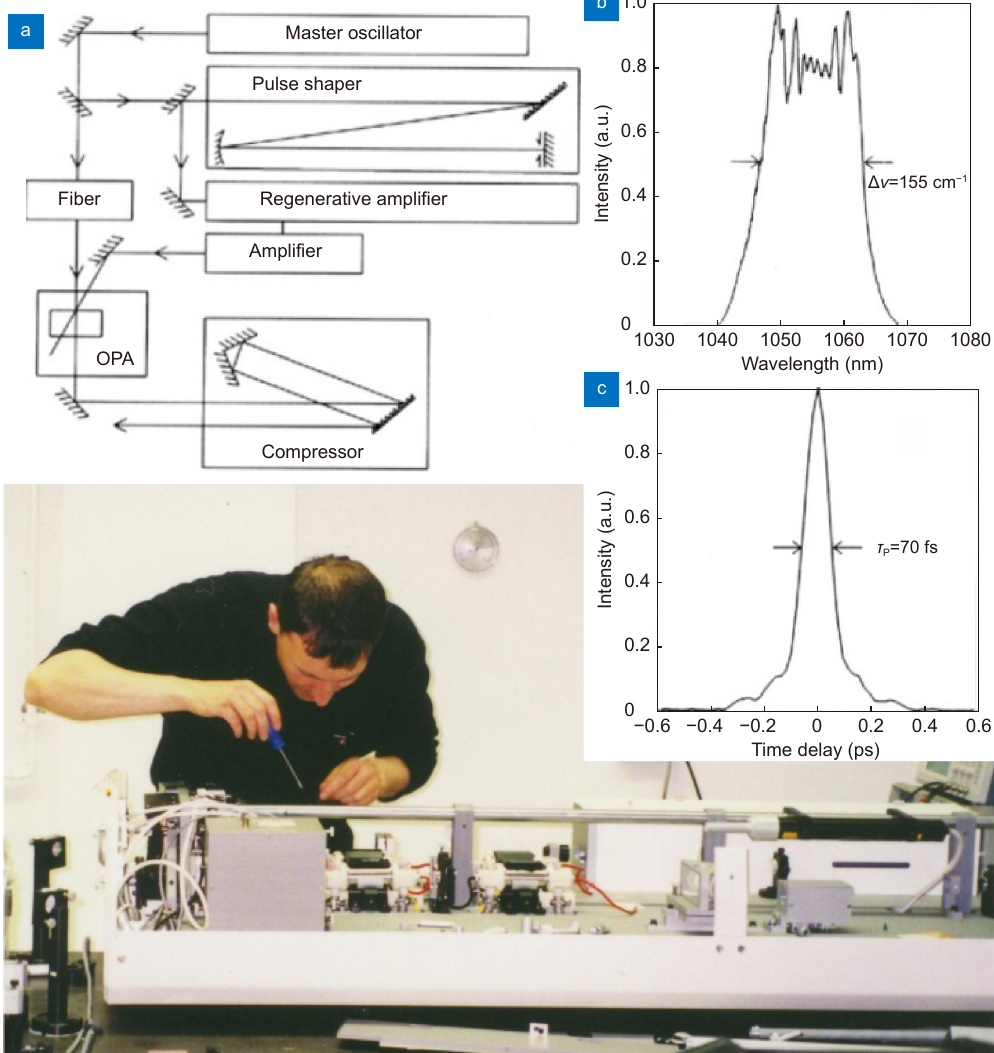
Fig. 1 | The first OPCPA . ( a ) Experimental setup. ( b ) Amplified spectrum. ( c ) Autocorrelation function of compressed pulse. Image at the bottom shows one of the authors (AD) aligning picosecond Nd:glass laser, which was used for driving the OPCPA experiment. Figure reproduced with permission from: (a–c) ref. 3 ,